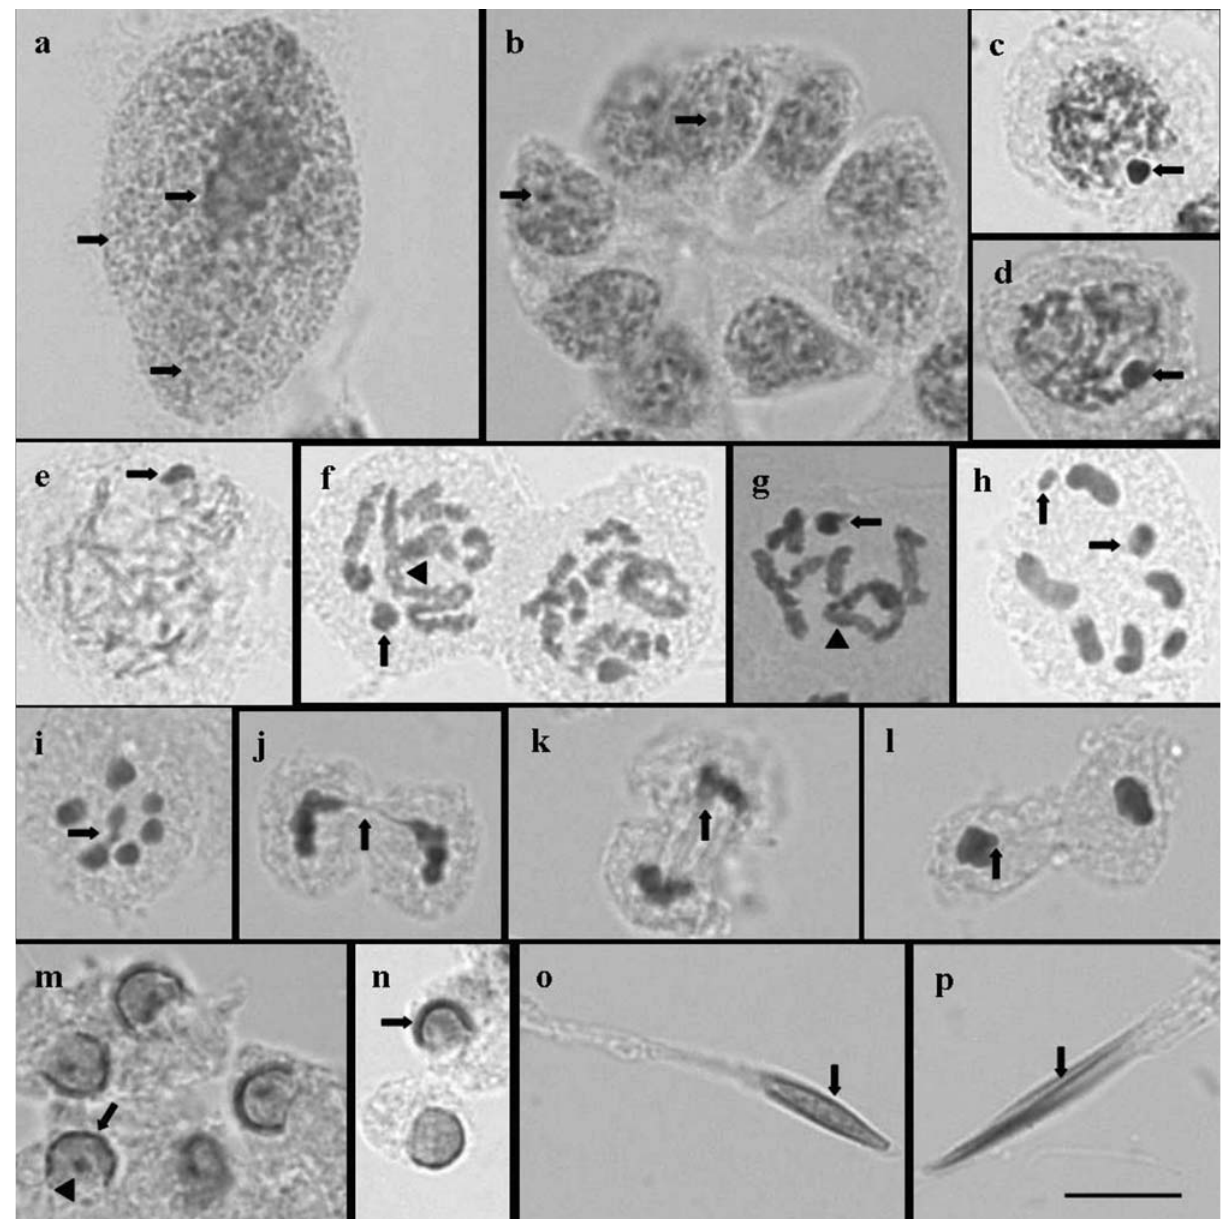
Figure 1 - Seminiferous tubule cells of Mormidea v-luteum (D, K, M and O), Oebalus poecilus (A, F, G, H, I, J, L, N and P) and Oebalus ypsilongriseus (B, C and E) adult males stained with lacto-acetic orcein. A) Polyploid nuclei of nutritive cells containing one large and many small heteropycnotic cor- puscles (arrows); B) Spermatogonial cyst constituted by nine spermatocytes, each one containing a heteropycnotic body (arrows); C-G) The single heteropycnoticcorpuscle(arrow)persistsduringtheentireprophaseI(inthesequence:leptotene,zygotene,pachytene,diploteneanddiakinesis);notethe presence of chiasmata in F and G (arrowheads); H) Metaphase I showing 2n = 12A + XY, the X (large) and Y (small) chromosomes are indicated by ar- rows; I) PolarviewofmetaphaseI,theautosomalbivalentsformingaringaroundthesexchromosomes(arrow); J-L) AnaphasesandtelophaseI;notethe late migration of the chromosomes (arrows); M) In round spermatids of Mormidea v-luteum , the heteropycnotic chromatin is present in the center of the nucleus forming a single corpuscle (arrowhead) and around the interior of the nucleus envelope arranged in a C- shaped structure (arrow); N) In the round spermatid of Oebalus species the heteropycnotic chromatin is exclusively present in the interior of the nucleus (arrow); O) Elongated spermatid of Mormidea showing the heteropycnotic chromatin maintained at the nucleus periphery (arrow); P) Elongated spermatid of Oebalus showing the hetero- pycnotic chromatin as a longitudinal line in the interior of the head (arrow). Bar = 10 μ